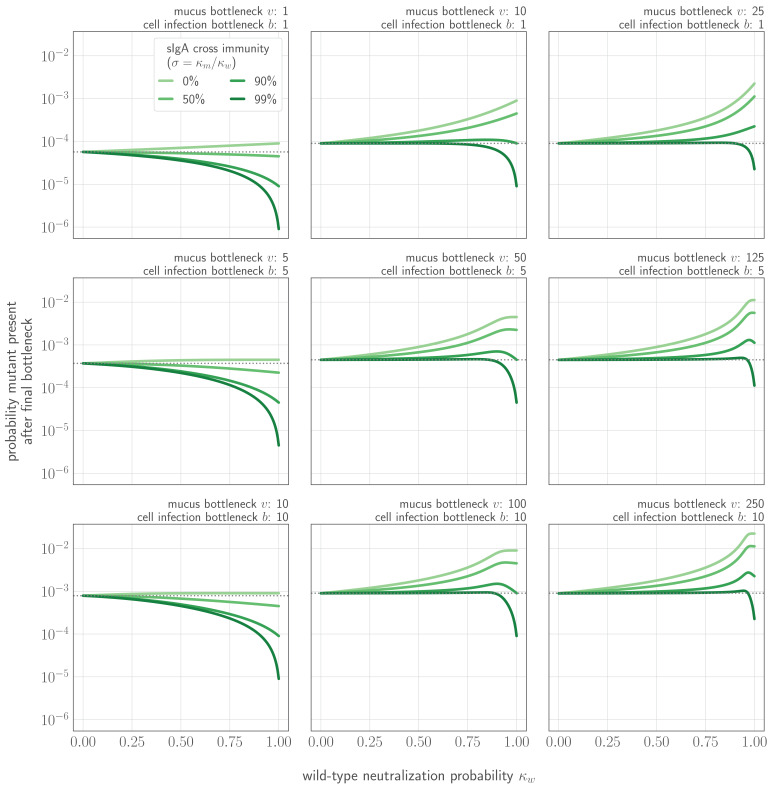
Probability that a new variant is present after the cell infection (final) bottleneck as a function of cross immunity and degree of competition for the final bottleneck.Probability shown as a function of probability of no old variant infection (zw), degree of cross immunity between mutant and new variant σ=κm/κw, mucus bottleneck size v, and final bottleneck size b. Gray dotted line indicates probability that a new variant survives the transmission bottleneck in a host who is naive both to the old variant and to the new variant (i.e. drift). fmt=9×10−5, a typical value for a naive transmitting host in stochastic simulations.